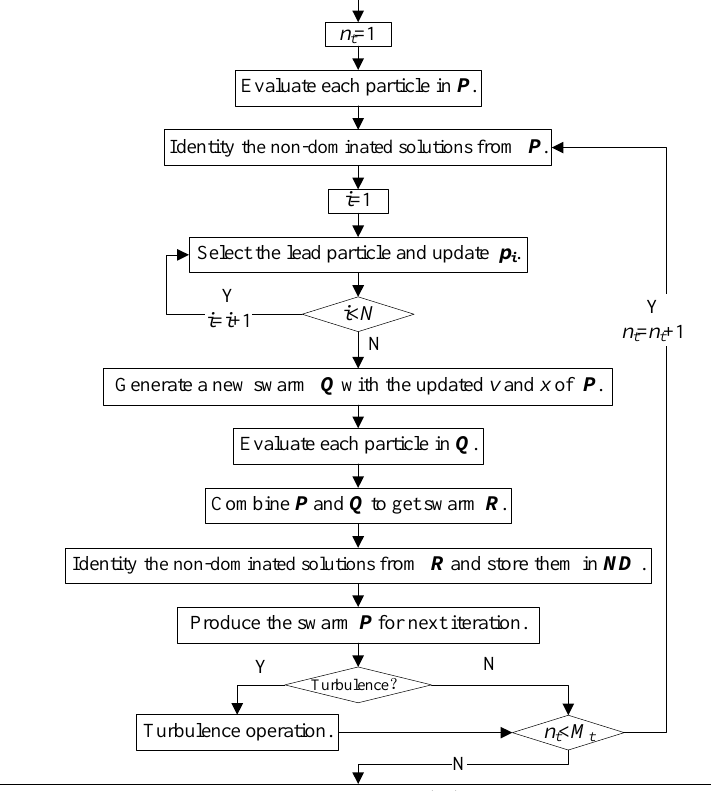
Figure 4. Scheme of identifying optimal solutions.